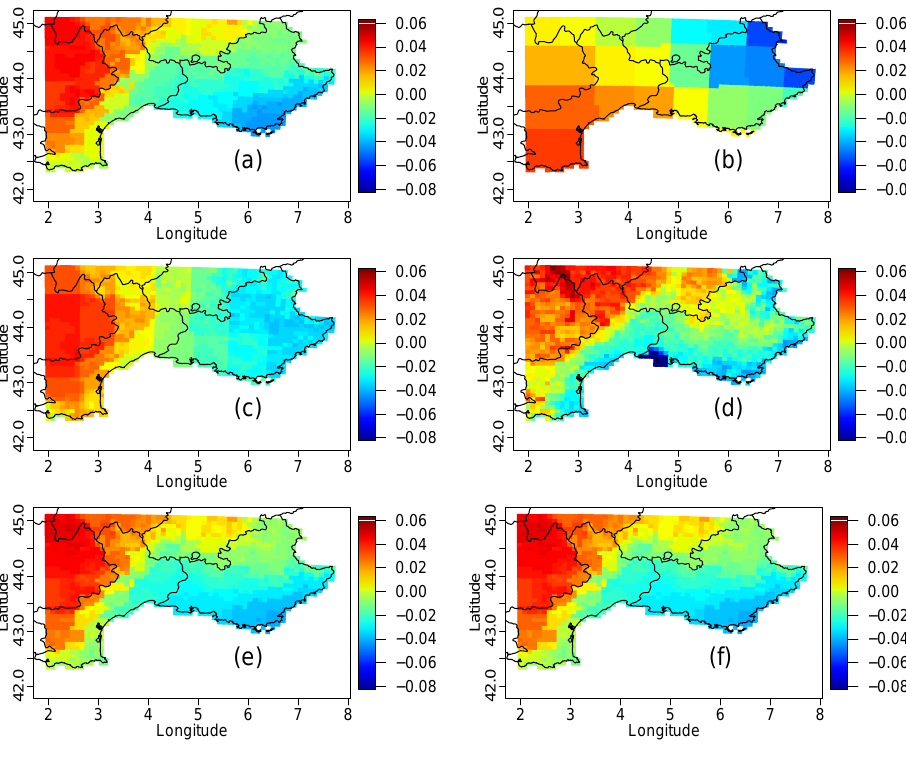
Figure 3. Same as Fig. 2 but for precipitation. Table 3. Values of S corr , corresponding to the sum of the absolute values of the elements of the difference correlation matrices for each dataset and for the different types of correlations (see text for details) in winter. Values have to be multiplied by 10 4 . Some methods and applications provide different S corr values depending on the reference dimension. For those cases, the mean S corr value is indicated and the standard deviation is indicated between brackets. Values in bold font indicate the smallest values for the